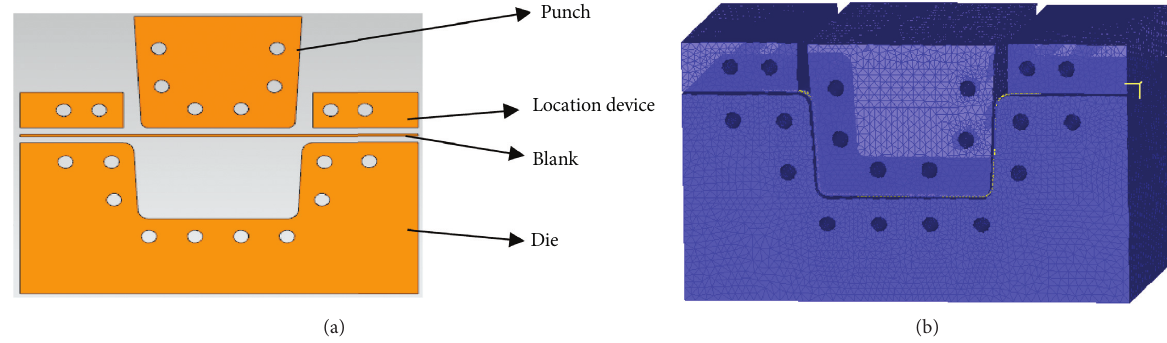
Figure 4: Establishment of the finite element model of the U-shaped part.